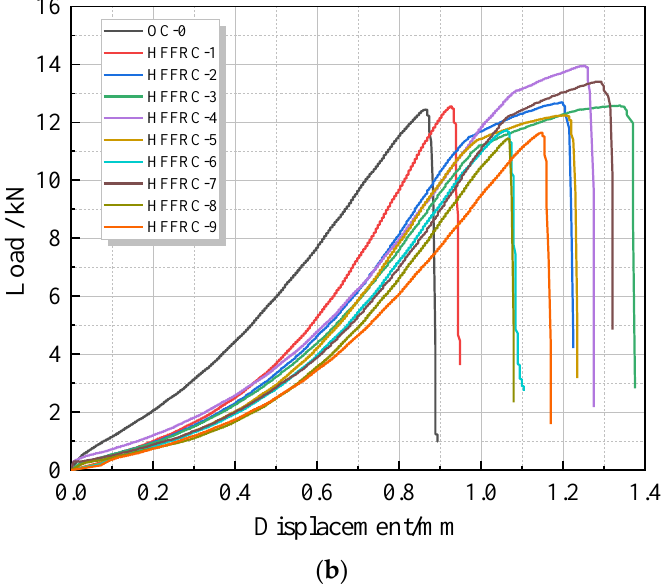
Figure 7. Load–displacement curves. ( a ) load–displacement curves in compression test; ( b ) load– displacement curves in flexural strength test.